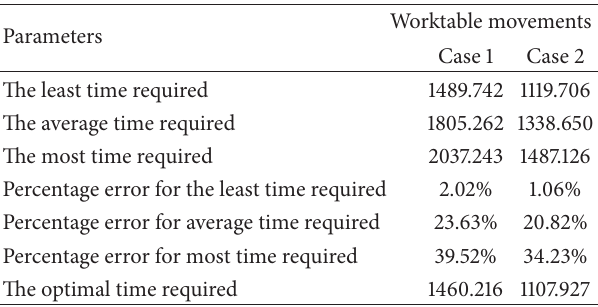
Table 3: Verification results for workpiece